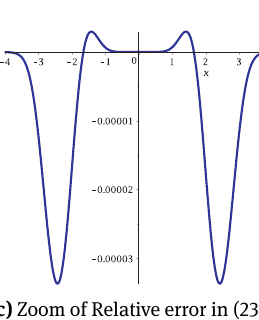
Figure 6: Error function approximations and relative